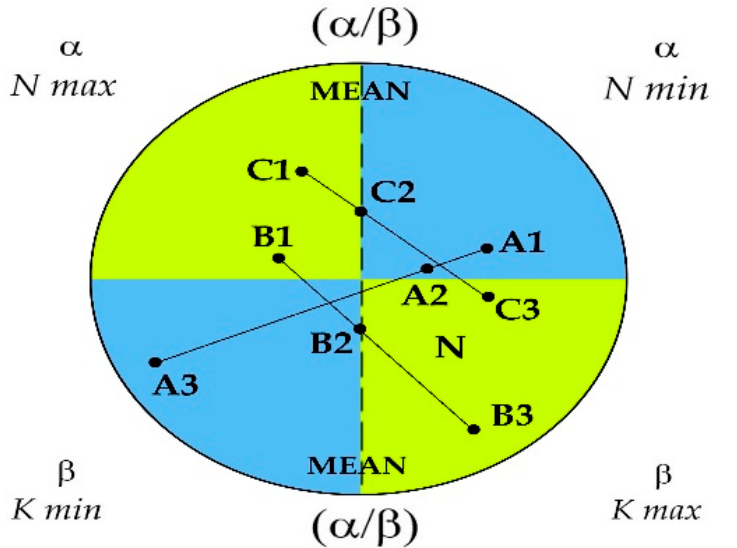
Figure 2. Example of the capture of three measured documentary tracks (A, B, C). The three parameters (N, α / β , K ) are used to locate each ‘assessment track’ in the triplet space.